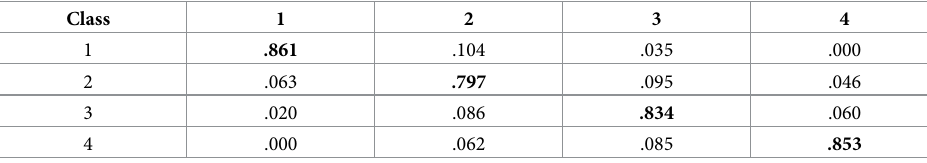
Table 4. Classification probabilities for the most likely latent class membership (column) by latent class